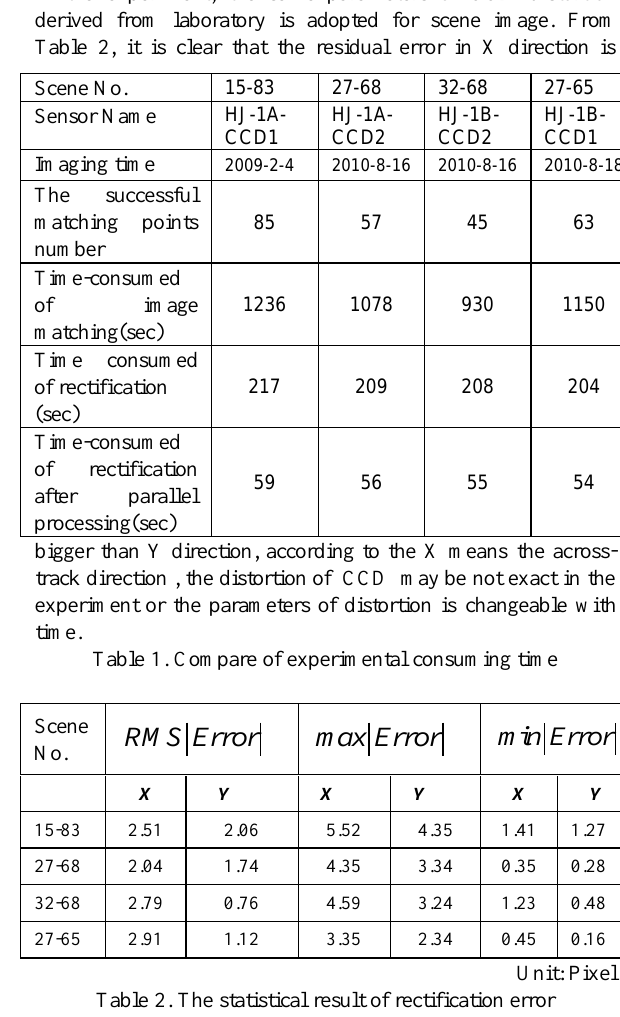
Table 2. The statistical result of rectification error